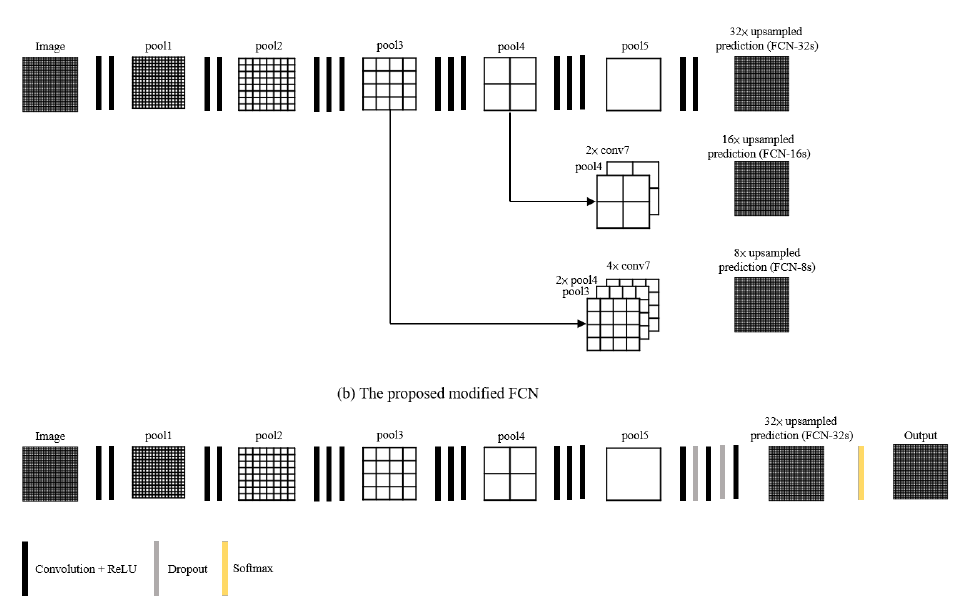
Figure 3. The comparison of the original FCN and the proposed modified FCN. ( a ) The architecture of original FCN. ( b ) The architecture of proposed modified FCN. Table 1. The architecture of the proposed deep learning